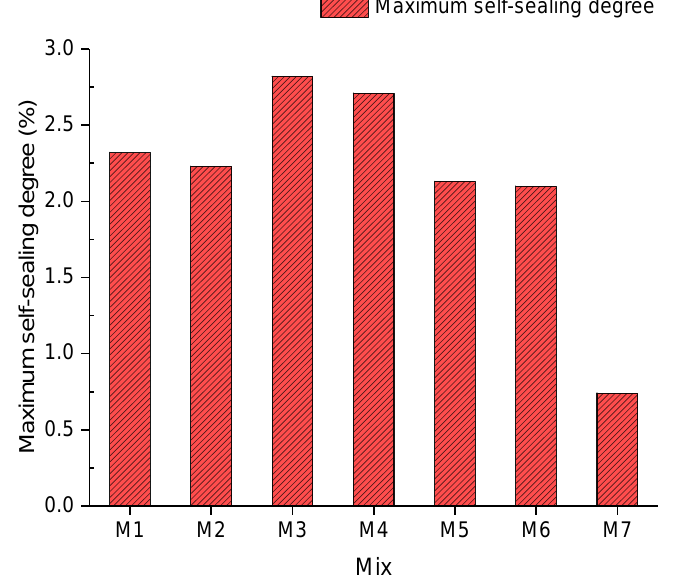
Figure 12. Maximum self-sealing degree.